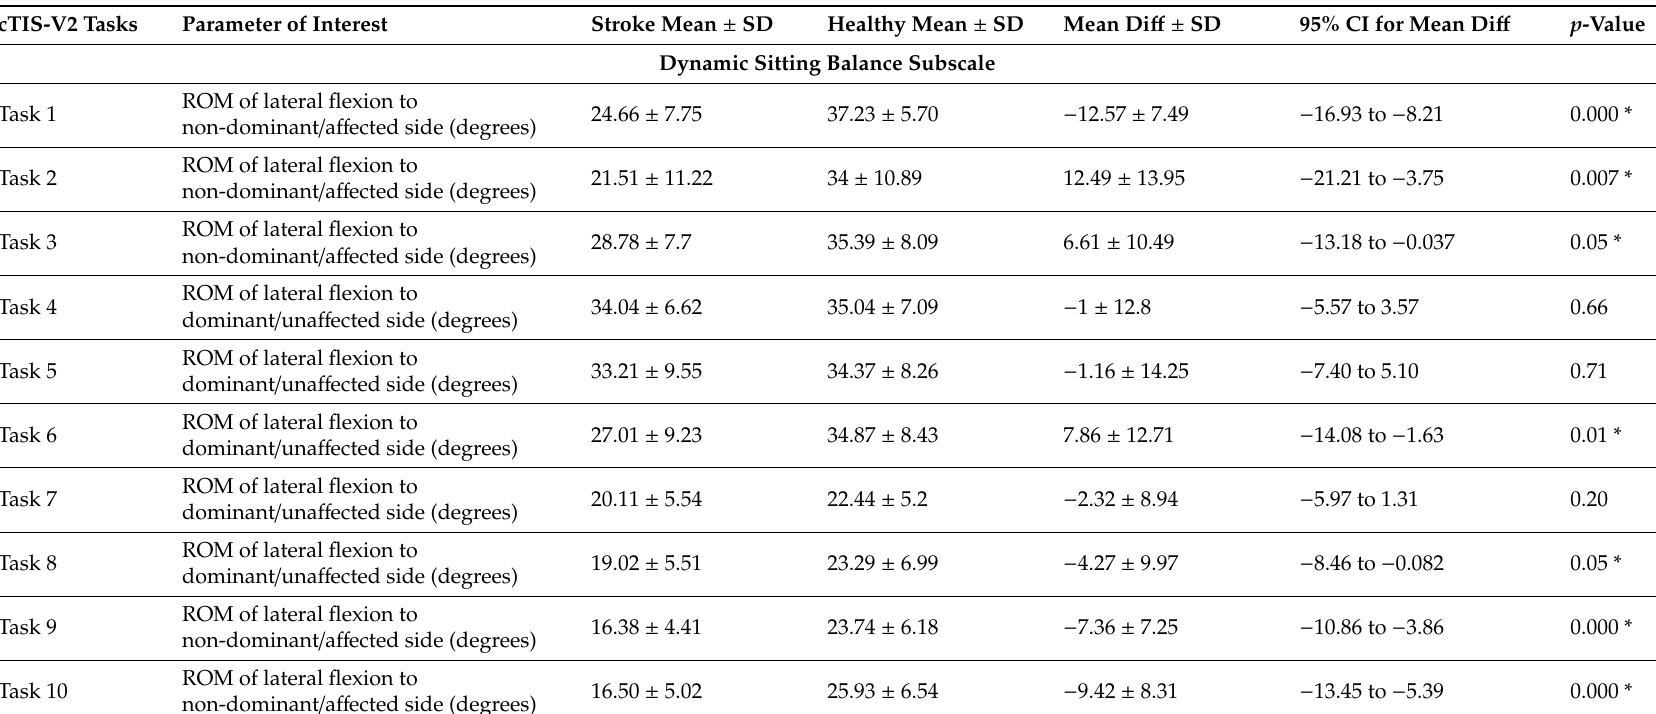
Table 5. Di ff erences in iTIS parameters between stroke and healthy